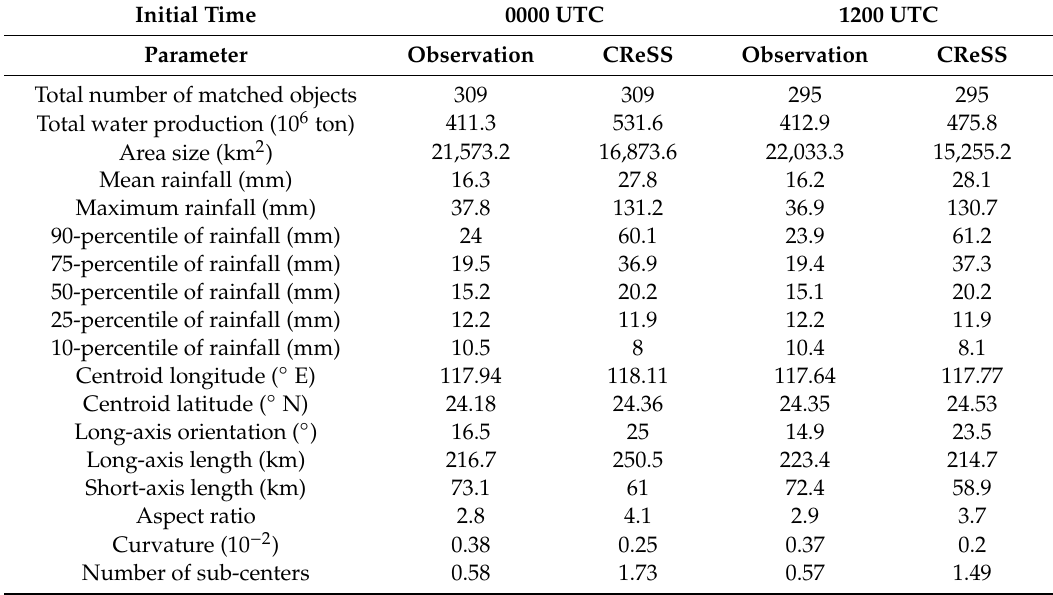
Figure 4. As in Figure 3, but for the matched object pairs at the same time (every 3 h), between the observation and CReSS QPFs at the range of 12–36 h, initialized daily at 00:00 UTC. ( a ) Total water production. ( b ) Characteristic length. ( c ) Maximum rainfall. ( d ) Mean rainfall. ( e ) Centroid longitude. ( f ) Centroid latitude. ( g ) Aspect ratio. ( h ) Long-axis orientation. ( i ) Object curvature. The number of objects successfully paired is 309. In panels ( a ), ( c ), and ( i ), the logarithmic scale is used in the vertical axis. Table 4. Mean value of major attributes of the matched rainfall object pairs (at 3-h intervals) in observation and CReSS forecasts at the range of 12–36 h, initialized daily at 00:00 or 1200 UTC. The data length is the same for both dataset (46